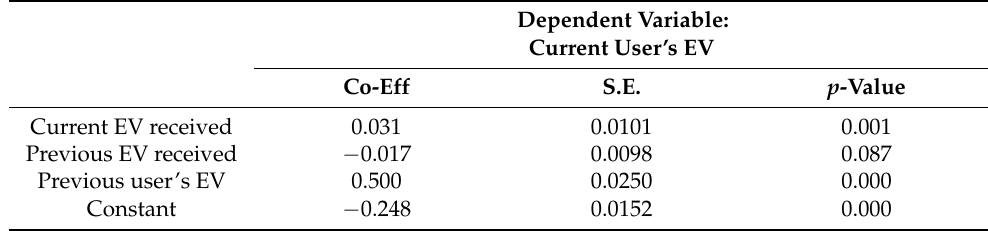
Table 1. Results of generalized estimation equation for emotional contagion.